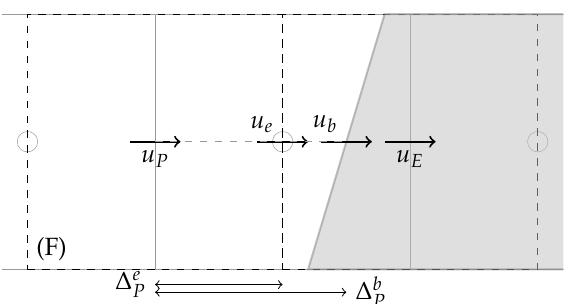
Figure 7. Interpolation for u e near solid boundary in which A u e is uncut, u E is within the solid and A p e =